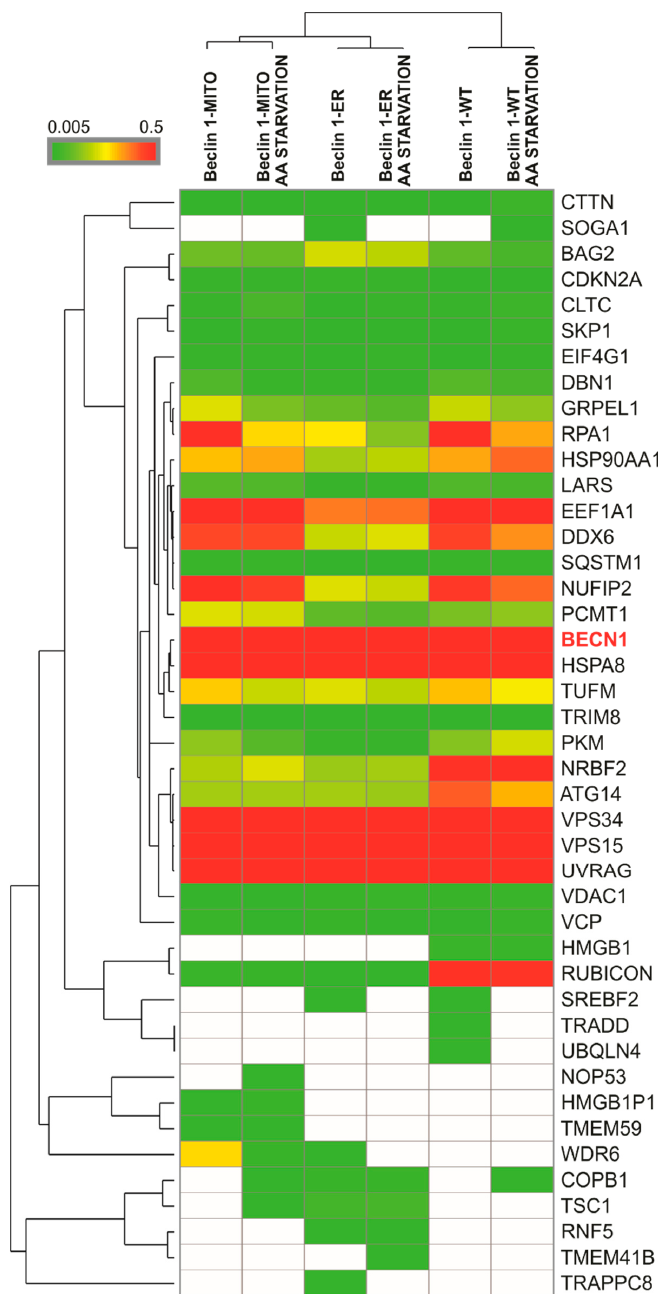
Figure 4. Heat map with hierarchical clustering of the interactors identified for the Beclin 1 constructs by affinity purification–mass-spectrometry (AP–MS). Stable HEK293 cell lines inducibly expressing Twin-StrepII-HA-tagged Beclin 1 constructs were induced by adding 2 μ g/mL tetracycline to the culture medium for 24 h, kept in full medium or starved in amino-acid (AA) free medium for 2 h. The interacting proteins of Beclin 1 were purified using Strep-Tactin beads and the purified proteins were analyzed using mass spectrometry. Heat map shows a summary of the interacting proteins of the Beclin 1 constructs. The colours correspond to protein-relative abundance, using normalized spectral counts (Beclin 1 bait abundance is set to 1). On the bait-normalized spectral count scale, red and shades of red correspond to abundant interactions between Beclin 1 constructs and the hits, while green and shades of green correspond to less abundant interactions. White colour indicates barely detectable or non-detectable interaction. Values are averages of three biological